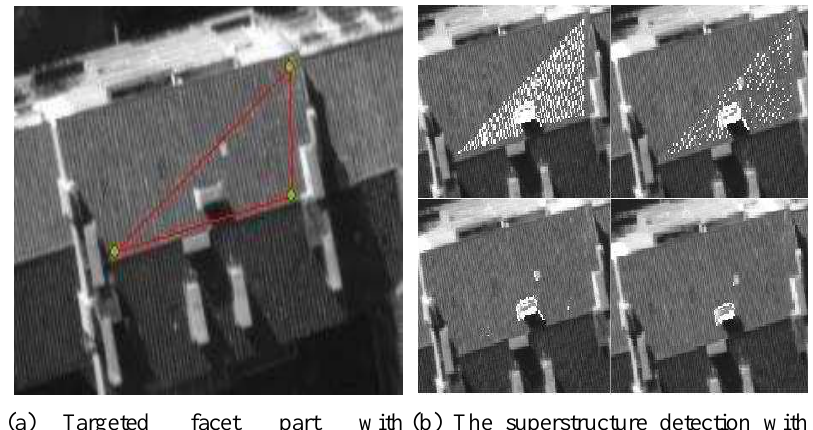
Figure 21. Filtering out the superstructures. (b) Tuning the k coefficient for the determination of the residual threshold T ( k = 0, k = 0.1, k = 0.2, k = 0.3, respectively, ). emp The removed pixels are shown in